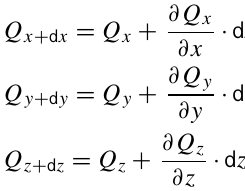
Figure 2. The interface of the developed software.